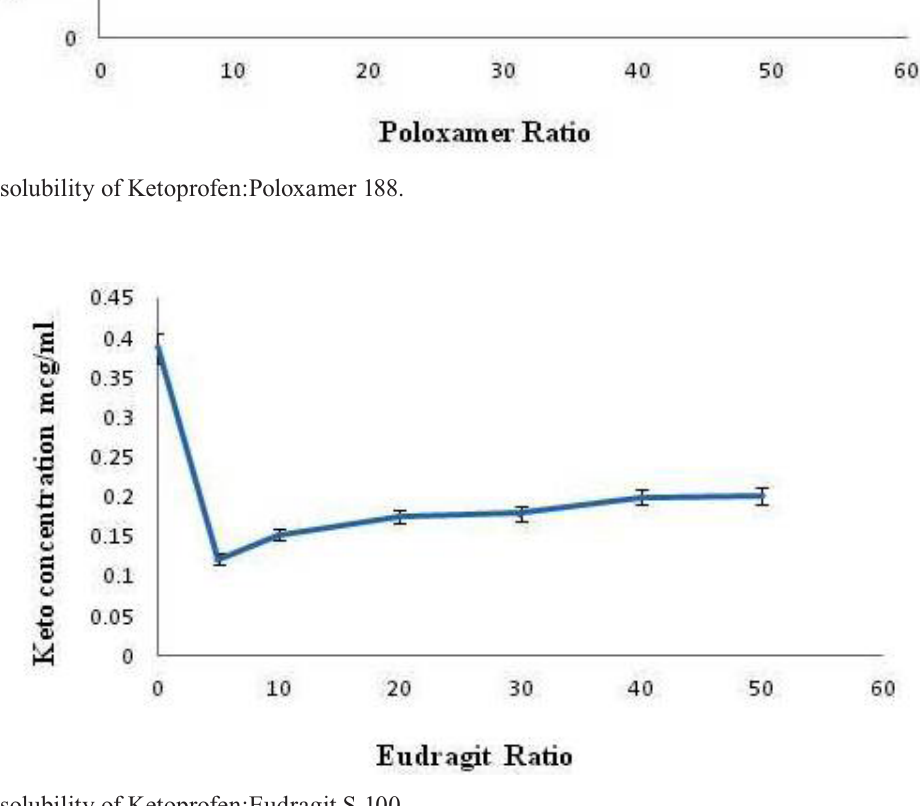
FIGURE 2 - Phase solubility of Ketoprofen:Eudragit